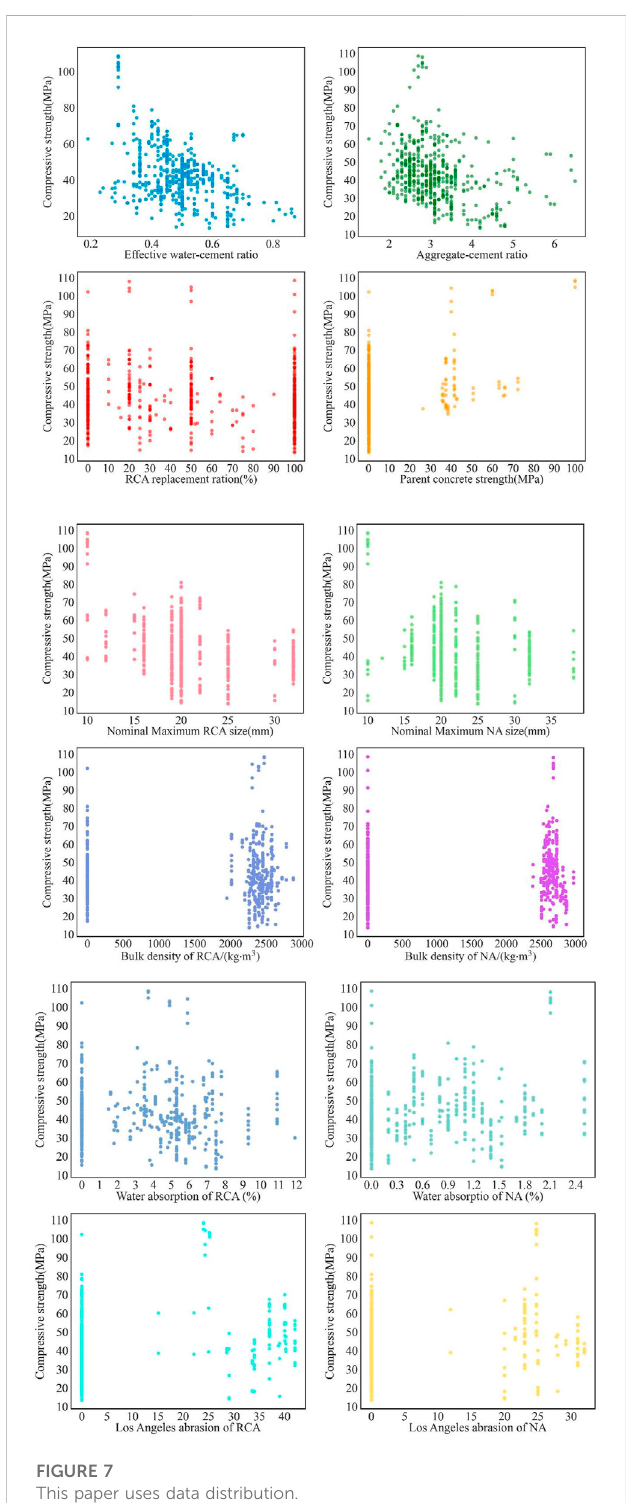
FIGURE 7 This paper uses data